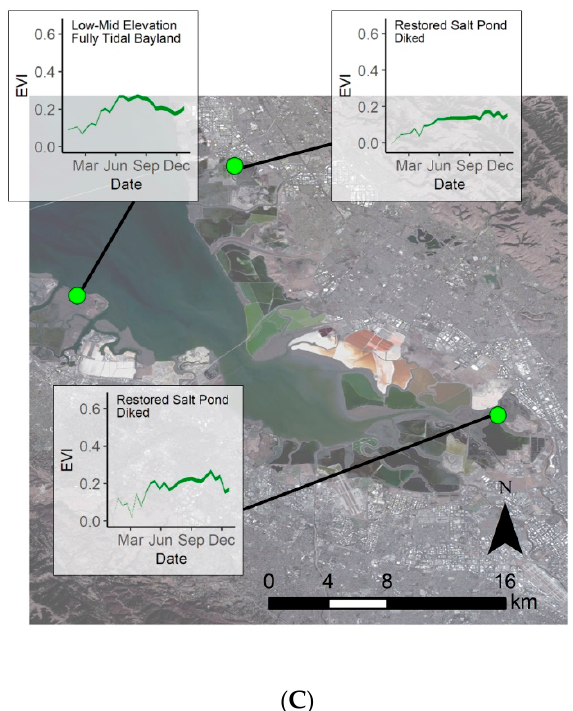
Figure 5. Modeled 2019 phenological envelopes at each of the 14 model development sites. ( A ) Represents the sites in San Pablo Bay, ( B ) the sites in Suisun Bay, and ( C ) the sites in South San Francisco Bay. Basemap: Landsat 8, U.S. Geological Survey.